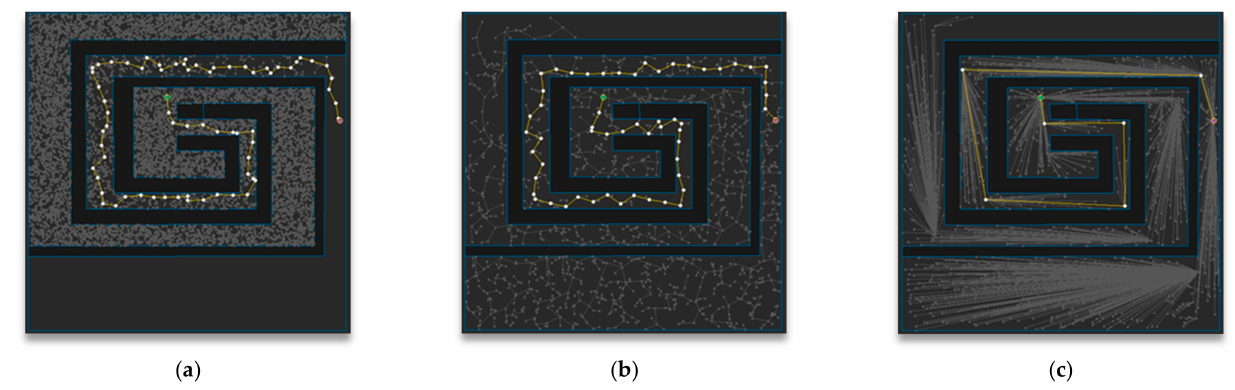
Figure 18. Experimental result of Map 8: ( a ) RRT; ( b ) RRT-Connect; ( c ) the proposed algorithm.